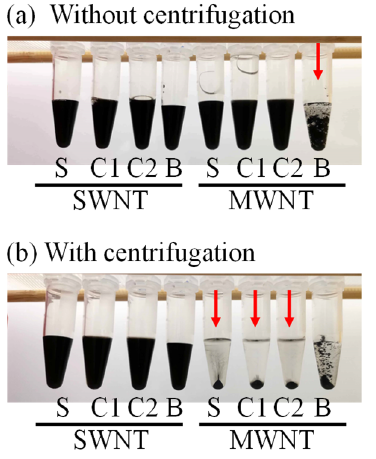
Figure 4. Photographs of prepared CNT suspensions. ( a ) Without centrifugation. ( b ) With centrif- ugation. S: SDS, C1: Coconut1, C2: Coconut2, B: